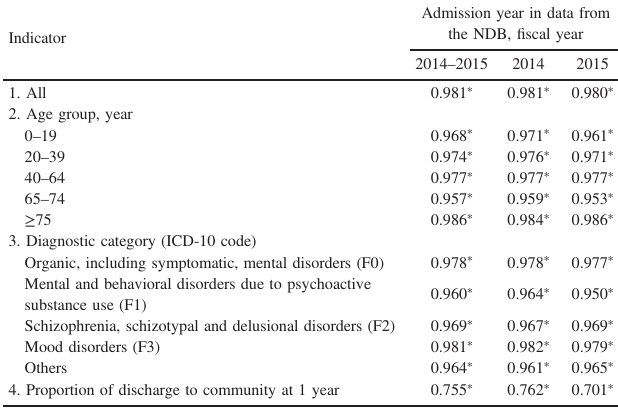
Table 4. Pearson correlation coe ffi cients for 4 indicators using data from the NDB and the 630 survey